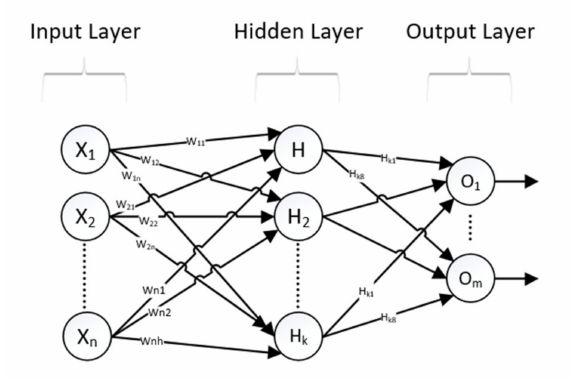
Figure 4. Three-layer neural network model [28].